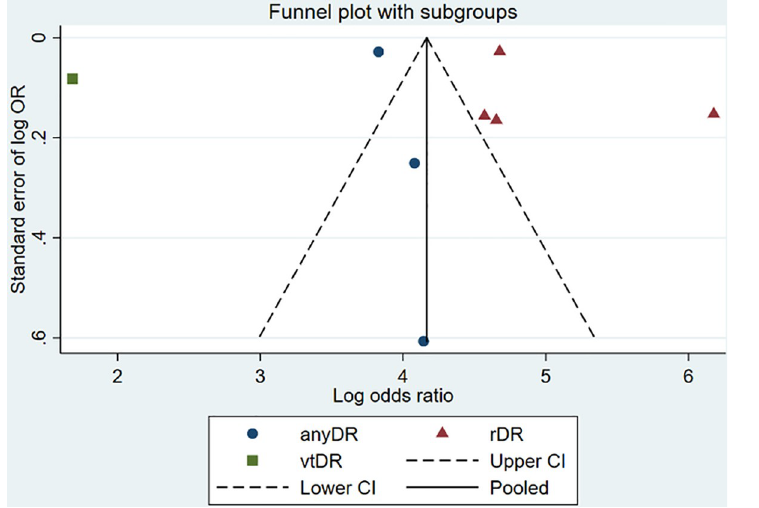
Fig 6. Funnel plot to assess publication